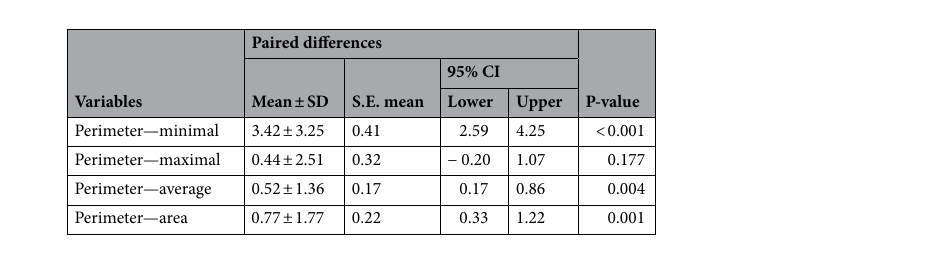
Table 3. Differences between size recommendations obtained using the perimeter-derived diameter and other diameters.